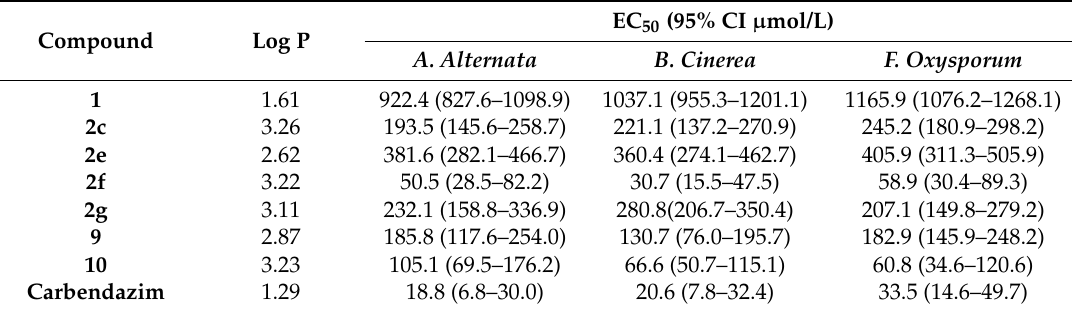
Table 2. EC 50 values and log P of effective compounds against three phytopathogenic fungi.